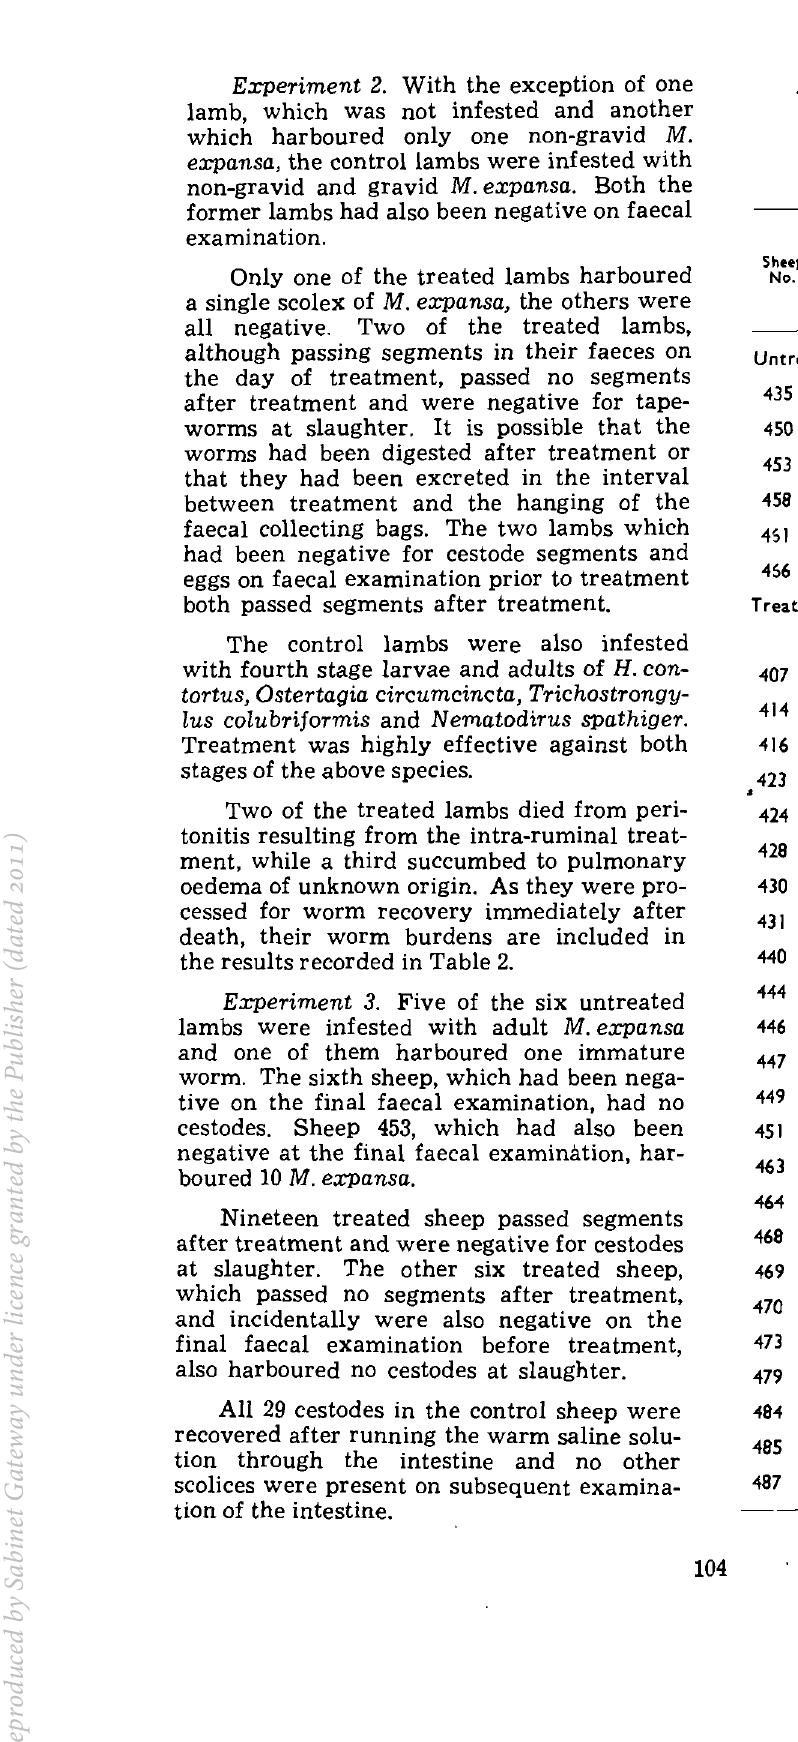
Table 3: SHEEP: EXPERIMENT l. CESTODE RECOVERIES